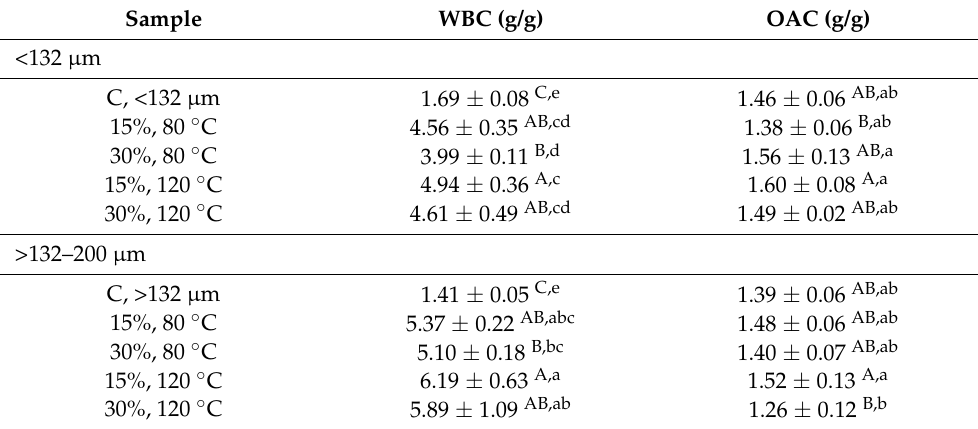
Table 3. Water binding capacity (WBC) and oil absorption capacity (OAC) of gluten-free flours.